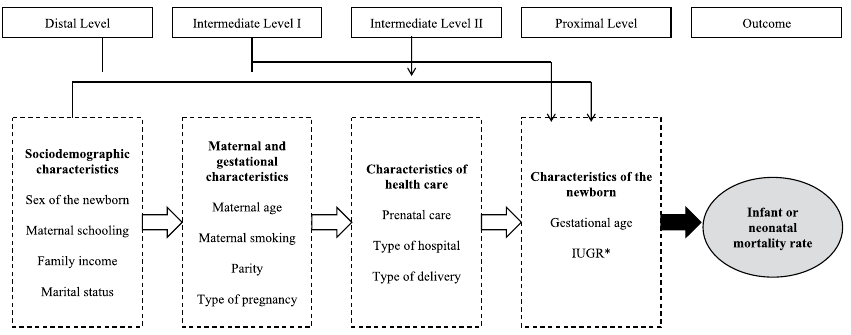
Figure 1. Hierarchical modelling for the analysis of factors associated with infant and neonatal